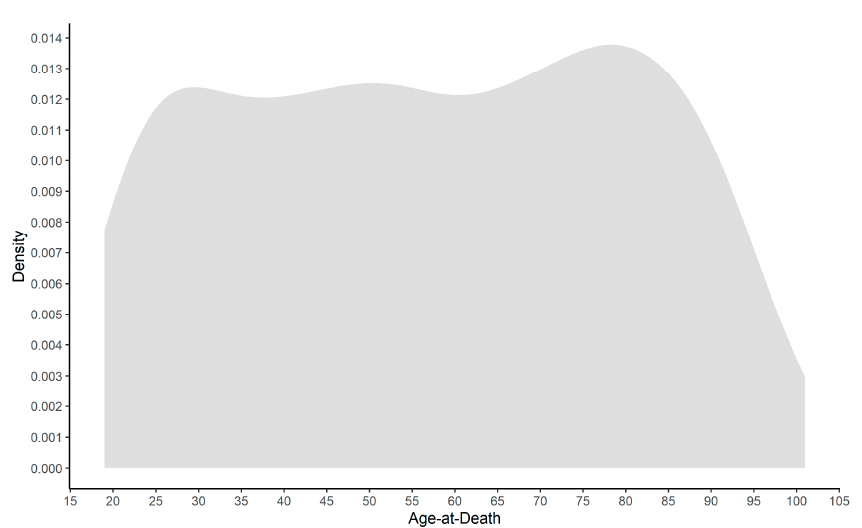
Figure 1. Pooled age-at-death distribution (KDE).